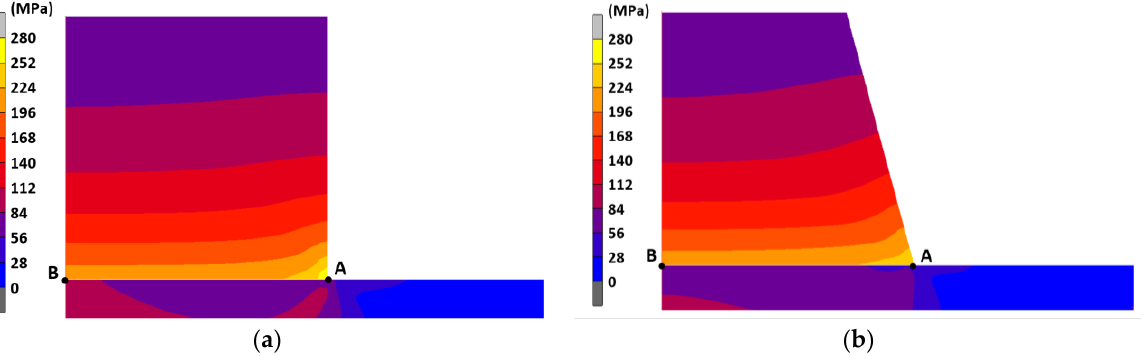
Figure 6. Hub von Mises stress fields obtained by FEM simulations for ( a ) a conventional hub; ( b ) a full–chamfer hub with a chamfer angle of α = 15°.